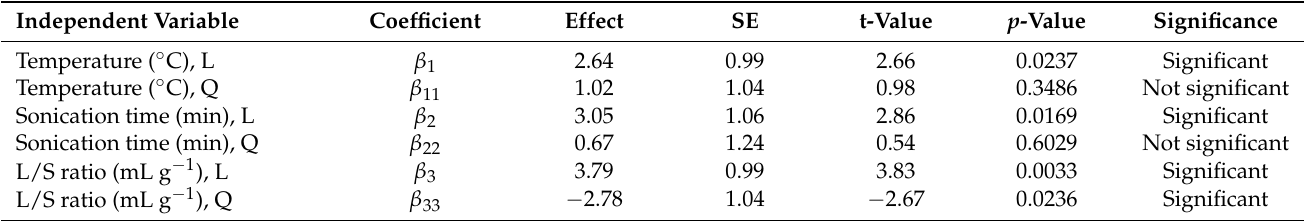
Table 4. Estimated effects for SCG oil extraction using n-hexane as